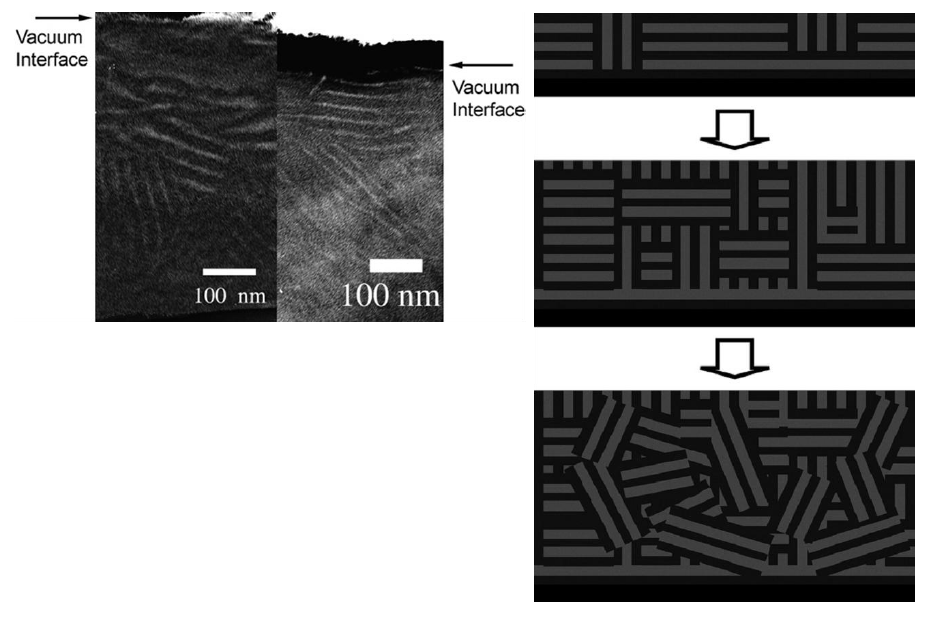
Figure 10. (Left) Cross-sectional TEM image of a rod-coil BCP film of PPV- b -PI. (Right) Schematic of morphology of a rod-coil BCP film as a function of film thickness. Reproduced with permission from Reference [74]. The Royal Society of